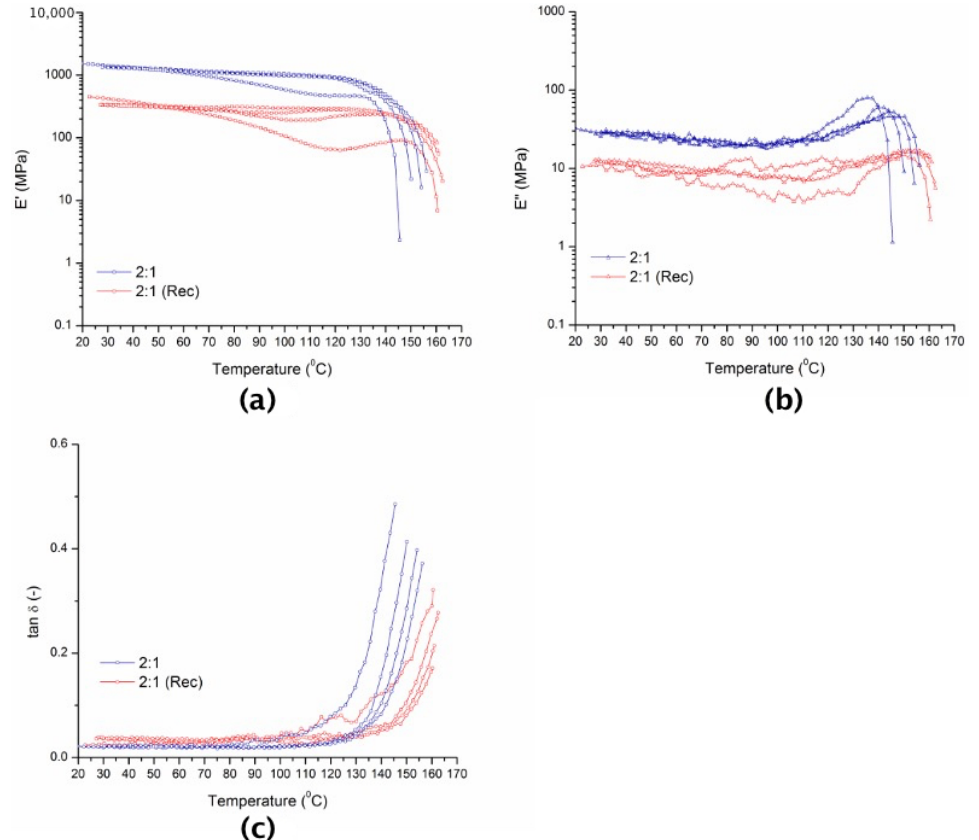
Figure 7. Dynamic Mechanical Thermal Analysis of recycled specimens of PE-fur/Bism ( a ) Storage modulus E’. ( b ) Loss modulus E”. ( c ) Damping factor tan δ.